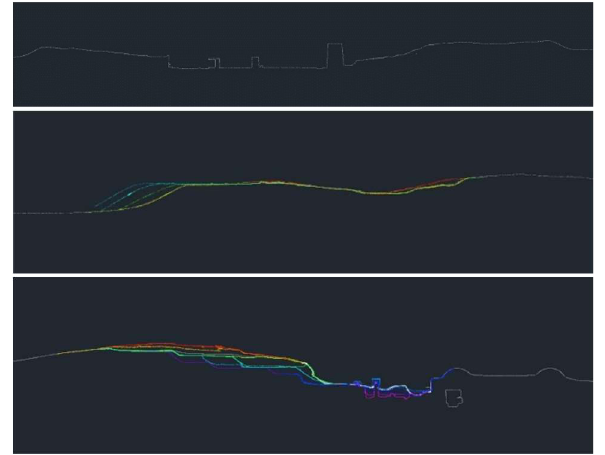
Figure 9. cross sections of excavation area, in grey the cross section of the DSM, in different colour the recorded levels of the excavation in different